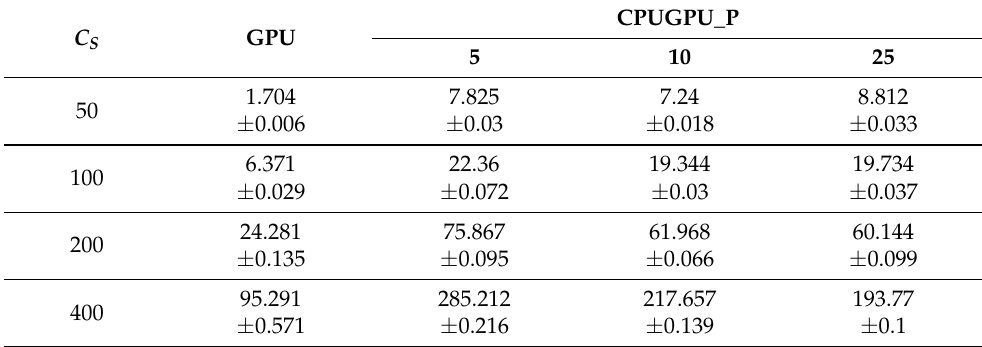
Table 4. Effect of number of simulations on computation time. Results of experiments for constant action without DNN ( C T = 100).